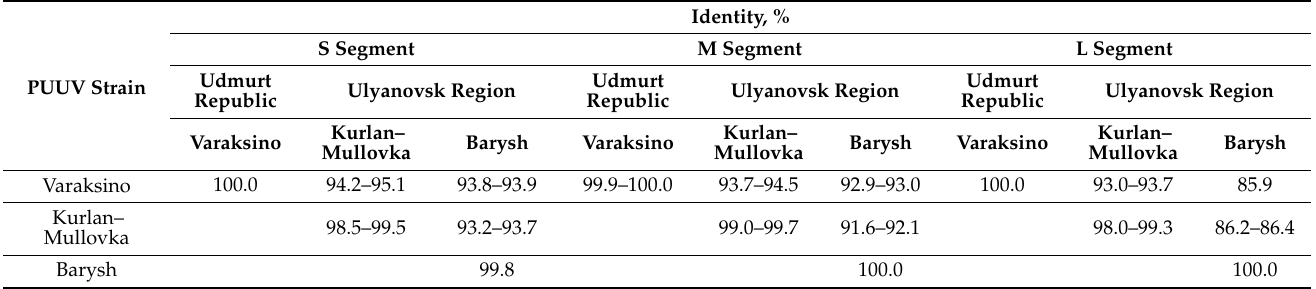
Table 2. Nucleotide sequence identity of the PUUV complete CDS S, partial M, and L segments recovered from bank voles (%) captured in ULR and UR areas.